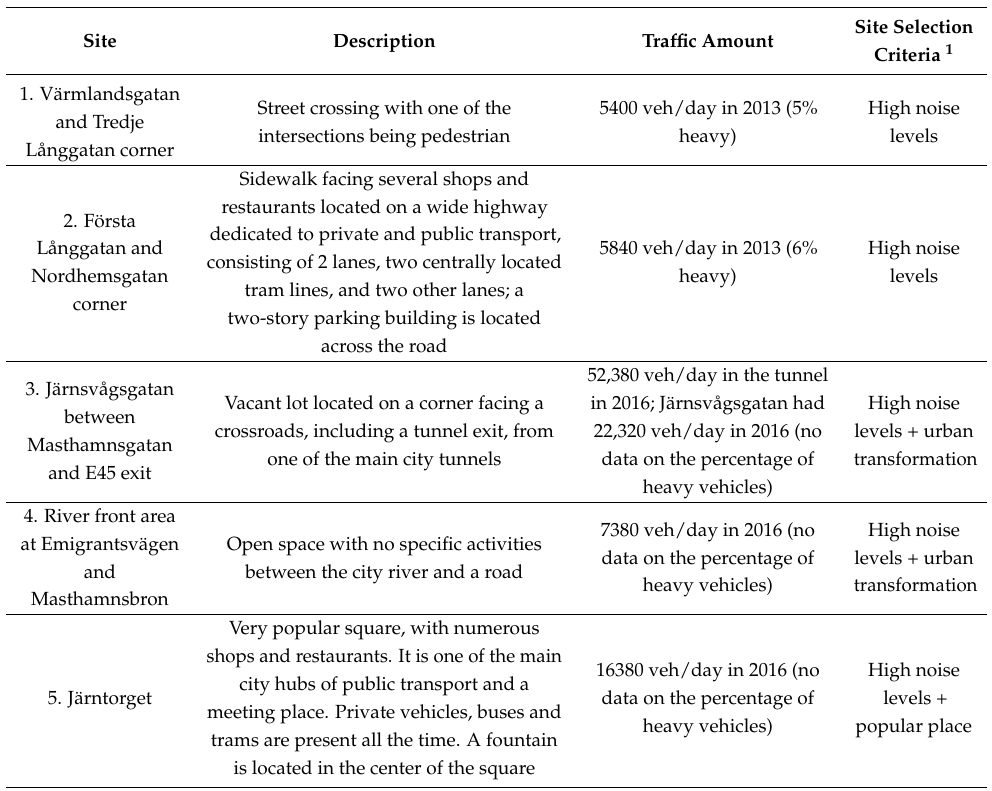
Table 1. Sites’ description and selection conditions.